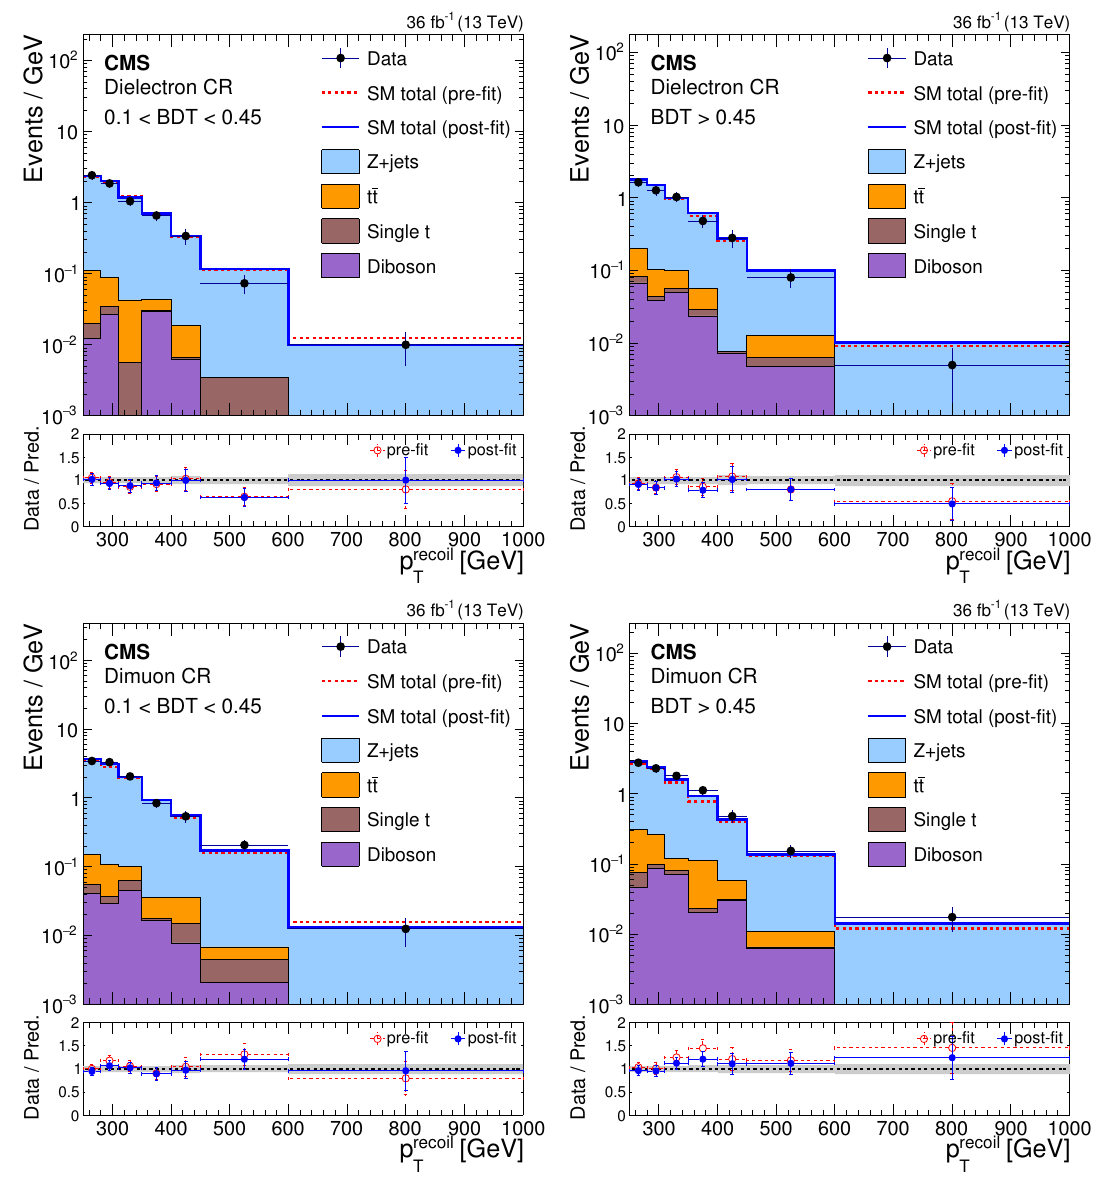
Figure 4 . Comparison between data and SM predictions in the dilepton control regions before and after performing the simultaneous (cid:12)t to the di(cid:11)erent control regions and signal region. Each bin shows the event yields divided by the width of the bin. The upper row of (cid:12)gures corresponds to the dielectron control region, and the lower row to the dimuon control region. The left (right) column of (cid:12)gures corresponds to the loose (tight) category of the control regions. The blue solid line represents the sum of the SM contributions normalized to their (cid:12)tted yields. The red dashed line represents the sum of the SM contributions normalized to the prediction. The stacked histograms show the individual (cid:12)tted SM contributions. The lower panel of each (cid:12)gure shows the ratio of data to (cid:12)tted prediction. The gray band on the ratio indicates the one standard deviation uncertainty on the prediction after propagating all the systematic uncertainties and their correlations in the (cid:12)t.